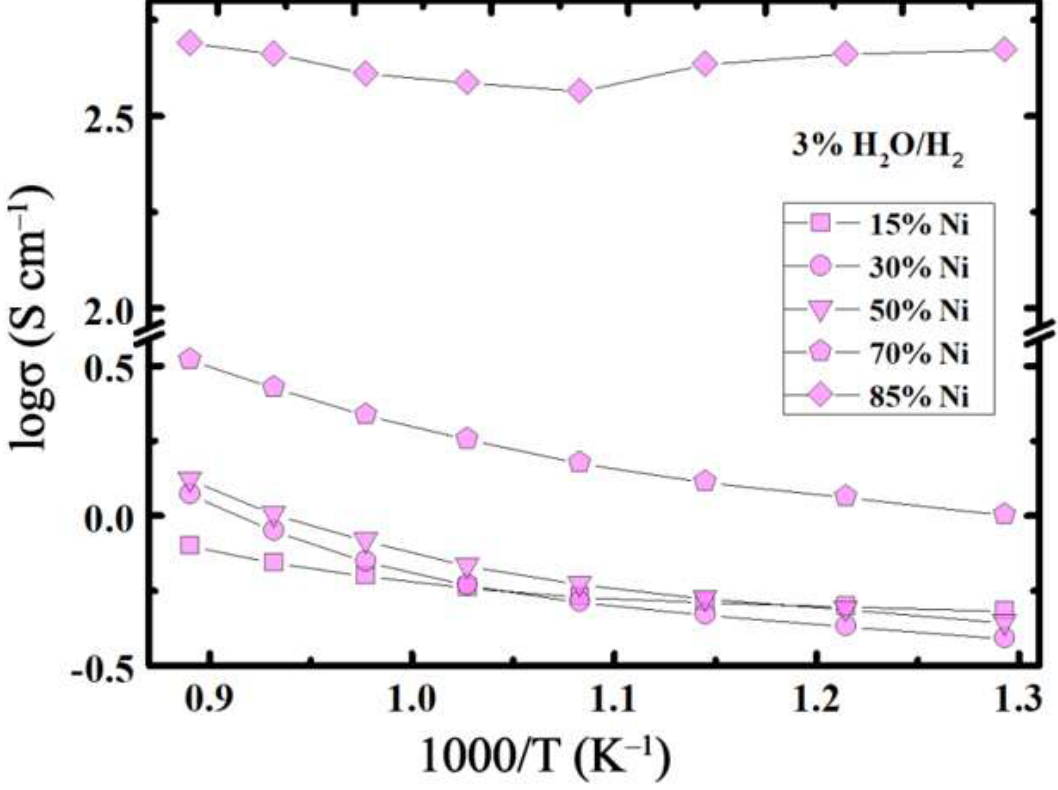
Figure 3. Temperature dependences of conductivity for the (1 − x)Sr 2 Mg 0.25 Ni 0.75 MoO 6 − δ + xNi composites in 3%H 2 O / H 2 atmosphere. Table 2. Electrical conductivity (at 800 °C) and activation energy value of the (1–